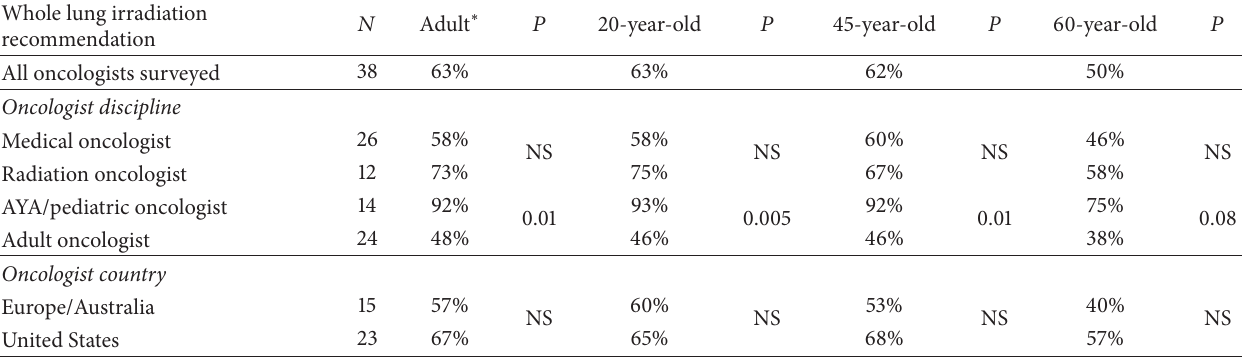
Table 1: Surveyed expert oncologists’ recommendations for whole lung irradiation for Ewing Sarcoma patients with pulmonary metastases in complete response following